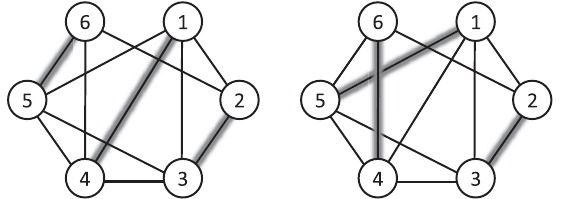
statistics.FIG. 8. An example of a six-node unweighted graph, described by the adjacency matrix in Eq. (A1). Two of the perfect matchings in the graph are shown with highlighted